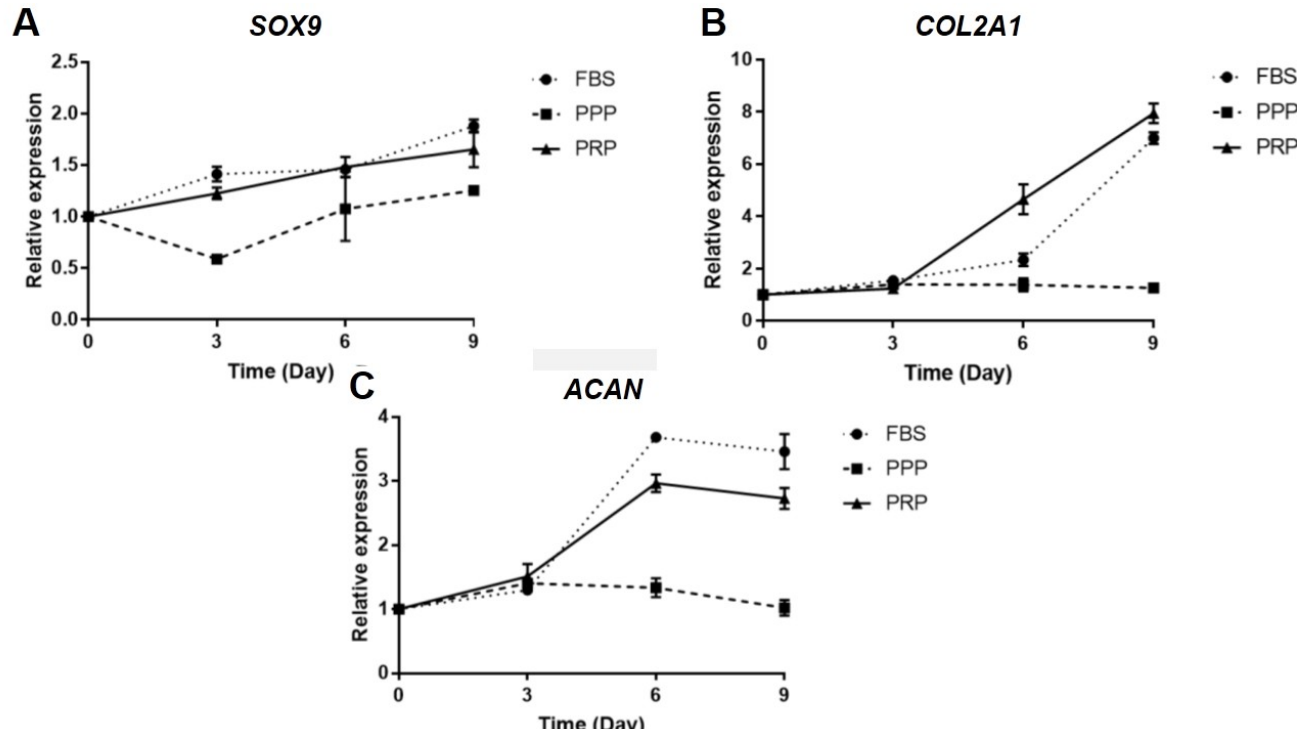
Figure 3. Effects of PRP, PPP, and FBS on expressions of cartilage-specific genes in knee OA chon-